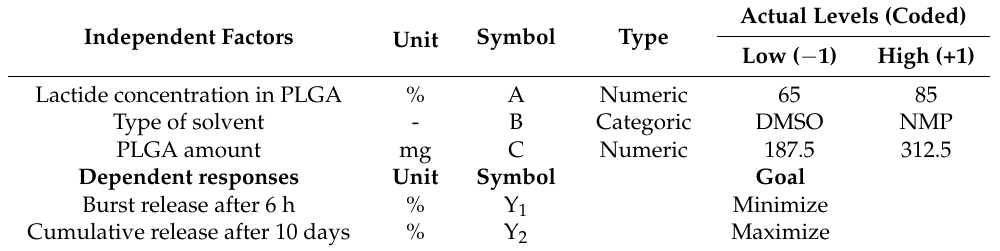
Actual Levels (Coded) Low ( − 1) High (+1)